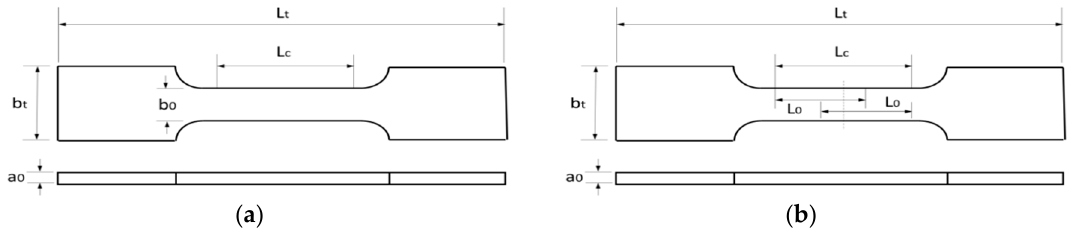
Figure 1. ( a ) Tensile specimen dimension; ( b ) Gage section and measurement distances.